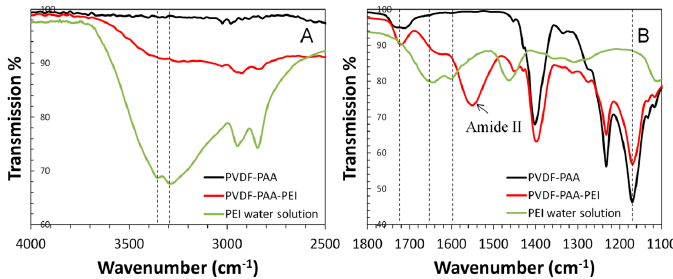
Figure 6. Attenuated total reflectance Fourier transform infrared spectroscopy (ATR-FTIR) of PVDF-PAA membrane ( black line), PVDF-PAA-PEI membrane ( red line), and polyethylenimine (PEI) solution ( green line).